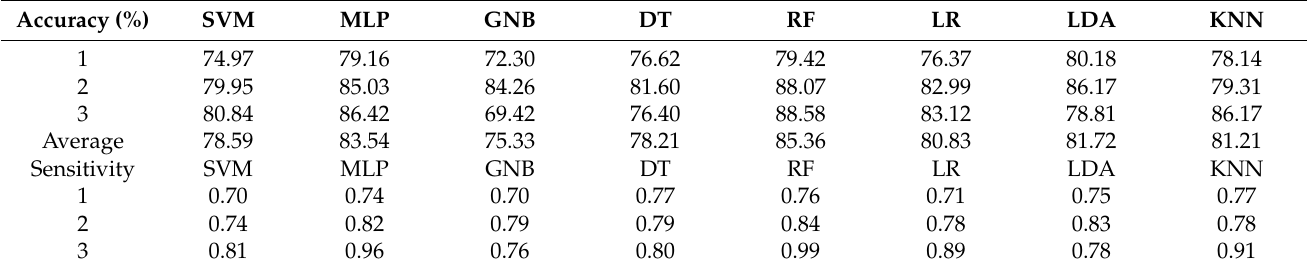
Table 2. Results of the machine-learning analyses comparing BPW indices between Data A (high quality) and Data B (low quality). Training and validation results are presented for the threefold cross- validation. For BPW indices, there were 1337 and 1026 pulses for Data A and Data B,